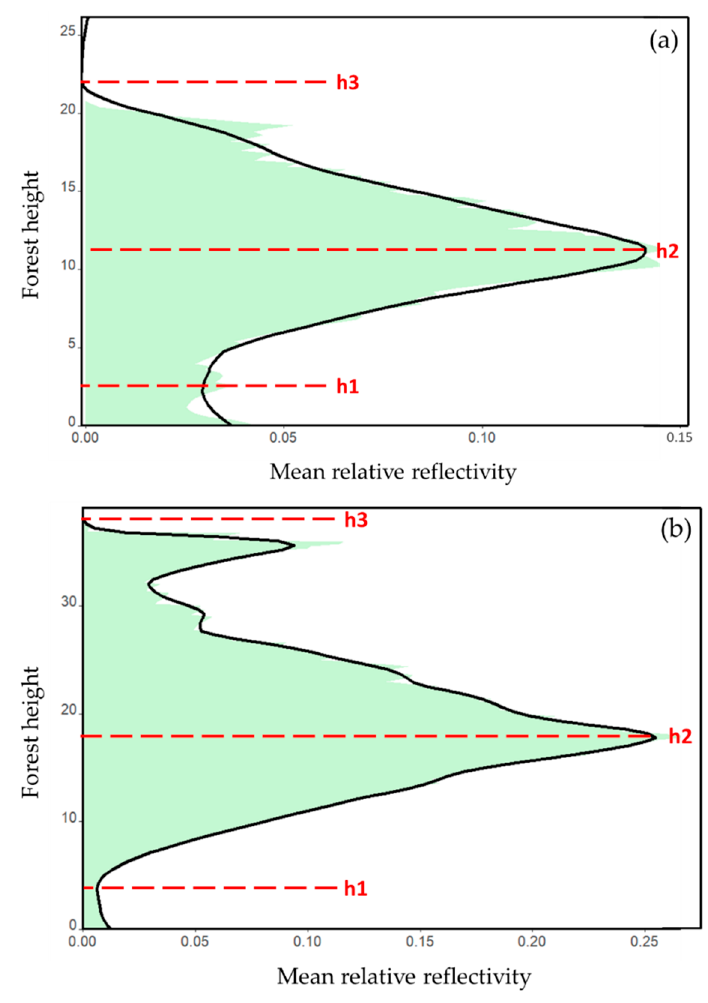
Figure 3. Mean relative reflectivity profile of two plots with ( a ) low and ( b ) high diverse structure.